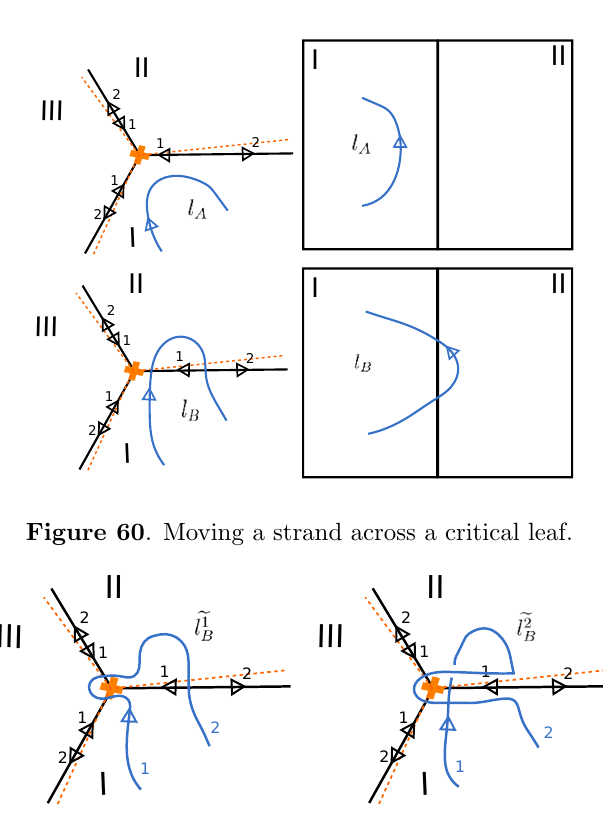
Figure 61 . Two lifts of l B whose contributions cancel each other.